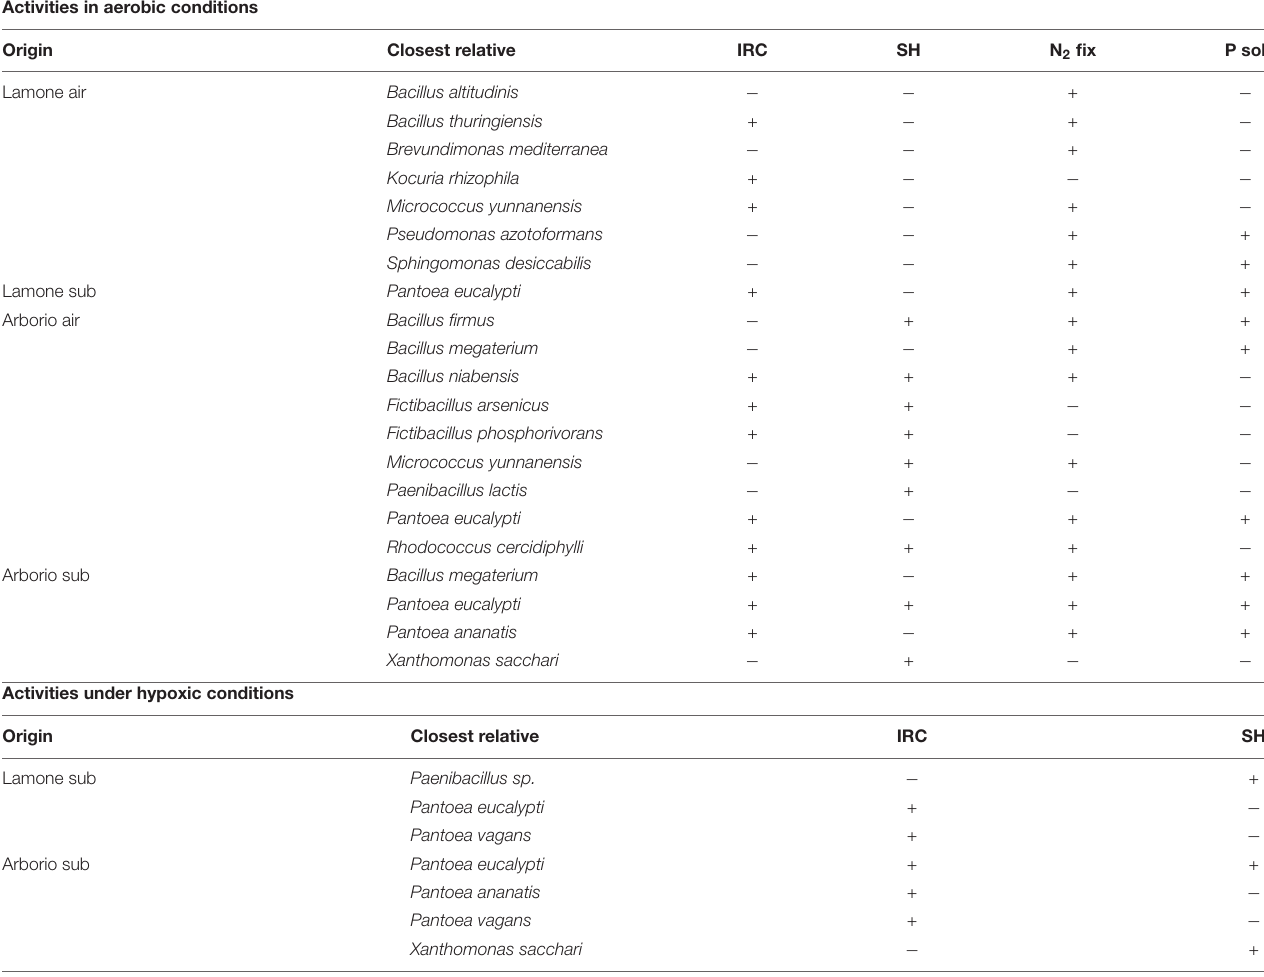
TABLE 3 | In vitro activities of putative endophytic bacteria isolated from Arborio and Lamone rice varieties and reported in Tables 1 , 2 .